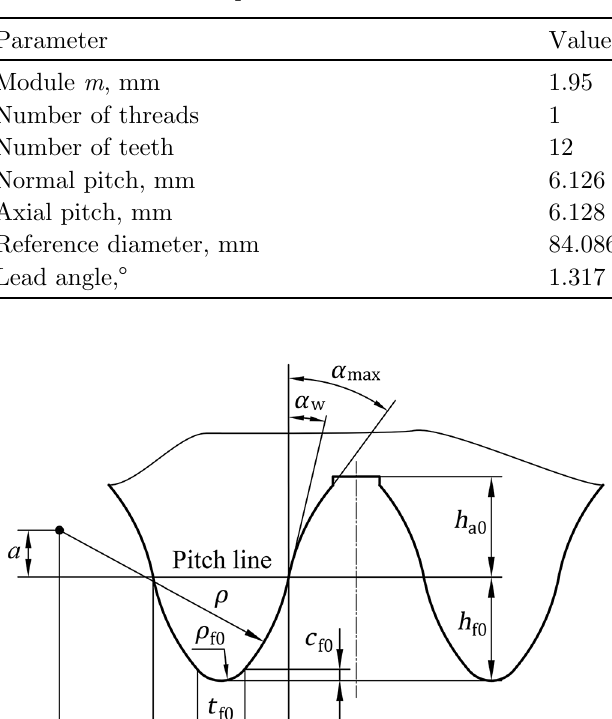
Table 4. Hob cutter parameters.